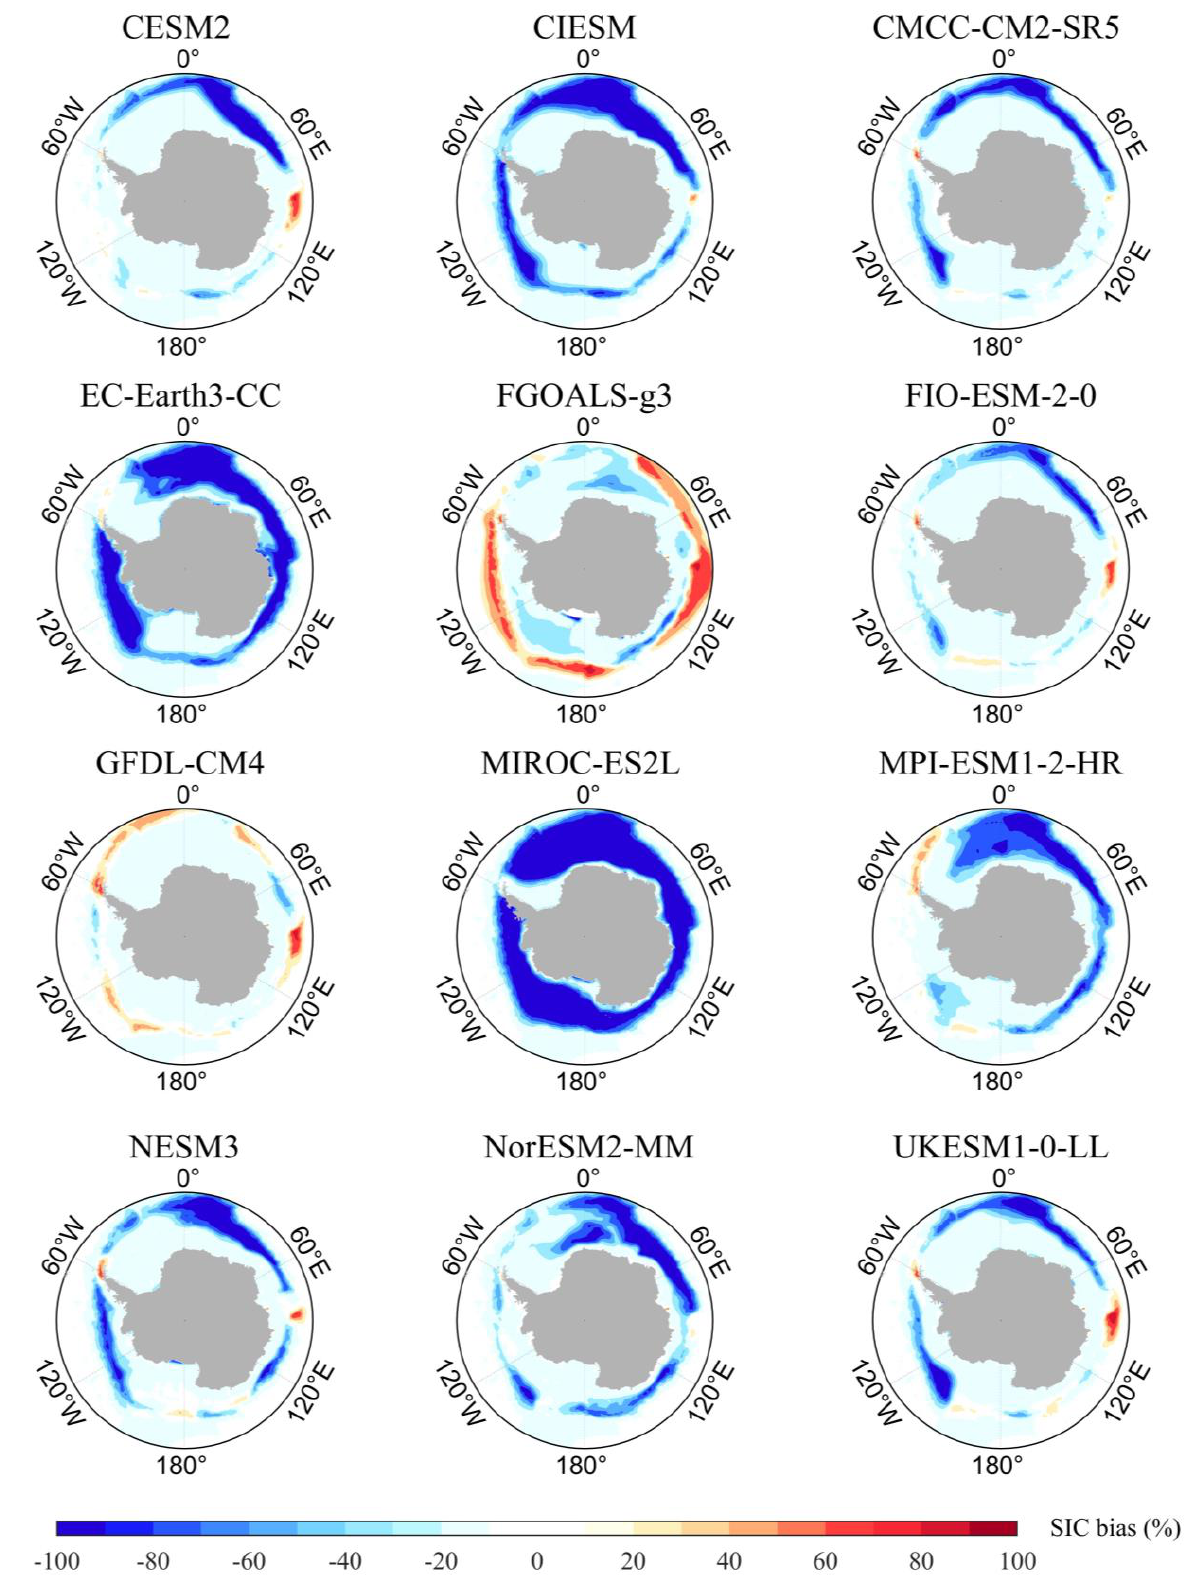
Figure 10. Spatial distributions of multi-year mean SIC difference in September between the CMIP6 models and the observation over the period 2015–2021.